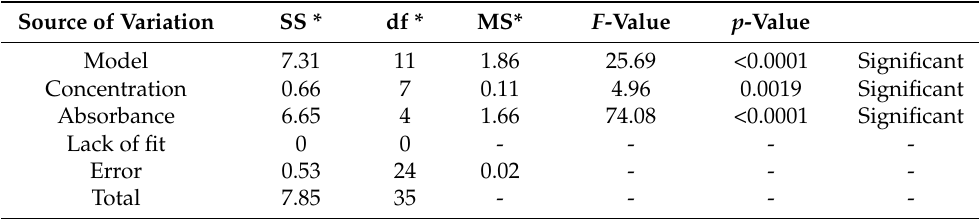
Table 7. ANOVA table of the minimum concentration for eradication of biofilm for MWCNTs_ZnO on the investigated strains.